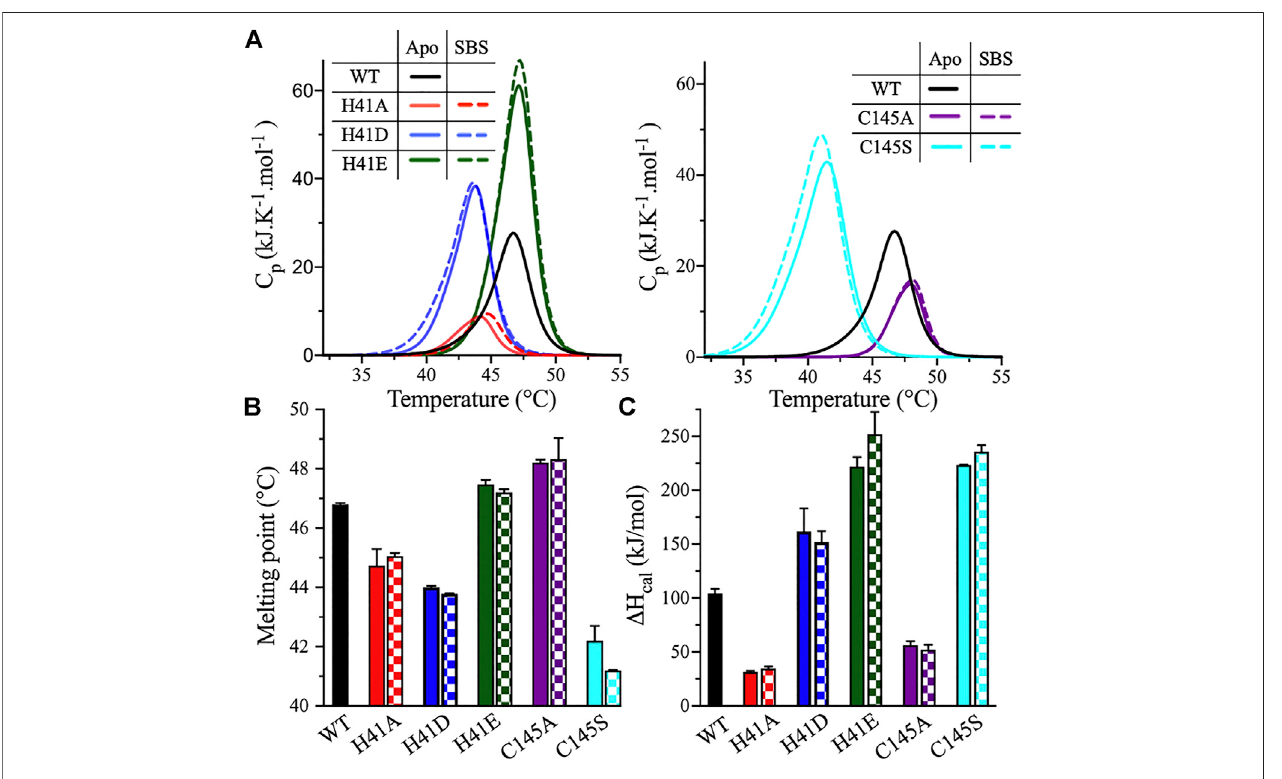
FIGURE 5 | DSC measurements of 3CLpro variants. (A) DSC thermal scans of 3CLpro WT, and its His41 and Cys145 variants acquired at pH 7.0 and 20% (v/v) DMSO. The sample was heated at a rate of 1.0 ° C/min, and the scans of the variants were acquired in the absence (solid line) or presence (dotted line) of 50 μ M peptide substrate.TheDSC scan ofWT enzyme was notacquiredin the presence of peptide substrate,as the protease iscatalyticallyactive. (B) Bar plot of T m calculated at the apex of the melting peak in the absence (solid bars) and presence (checkered bars) of 50 μ M peptide substrate. Colors are as in panel A. (C) Bar plot of Δ H cal calculated from the area under the thermographic peak in the absence (solid bars) and presence (checkered bars) of 50 μ M peptide substrate. Colors are as in panel A. Data presented in (B) and (C) are shown as the mean + SD, n (cid:2) 3.